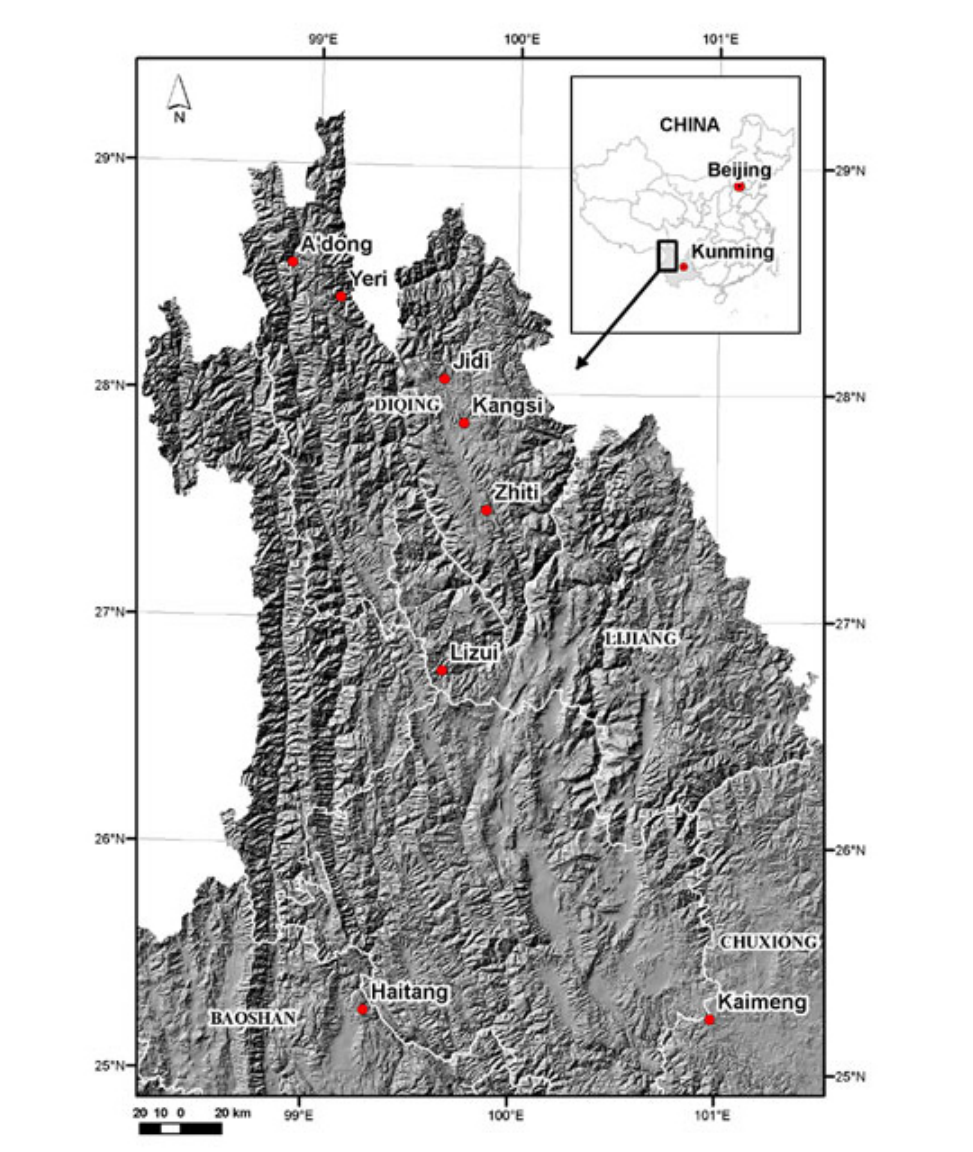
Fig. 2. Location of research